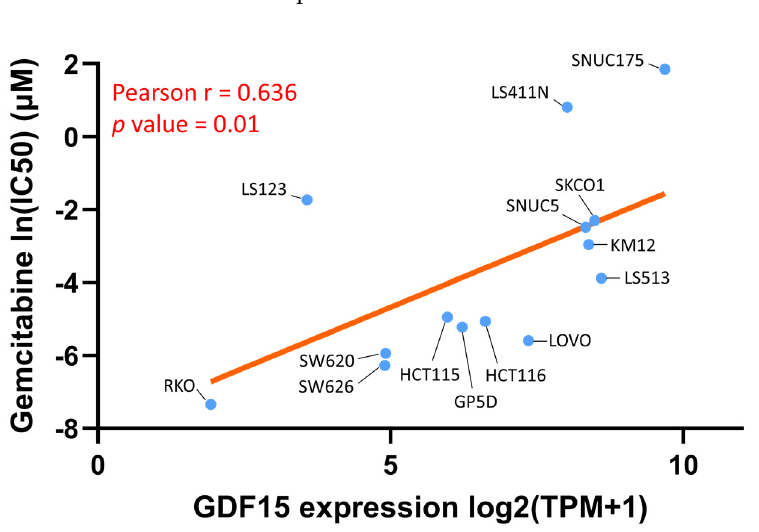
Figure 9. The relationship between GDF15 expression levels and Gemcitabine sensitivity in 14 COAD cell lines. The Pearson’s correlation of GDF15 expression levels were expressed as log2 of transcripts per million (TPM), and Gemcitabine sensitivity was expressed as the nature log of IC 50 .